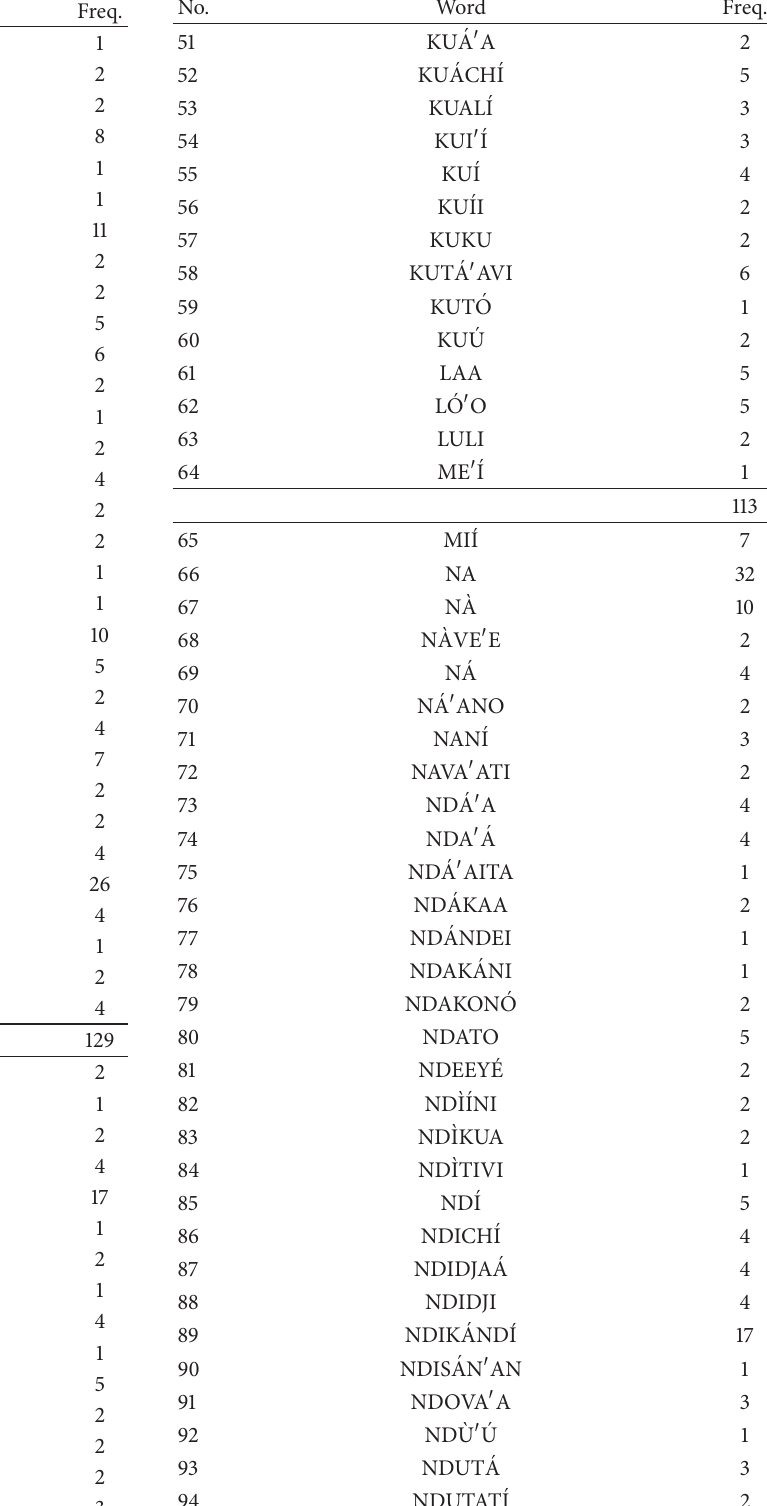
Table 3: Frequency of the vocabulary in the Mixtec speech